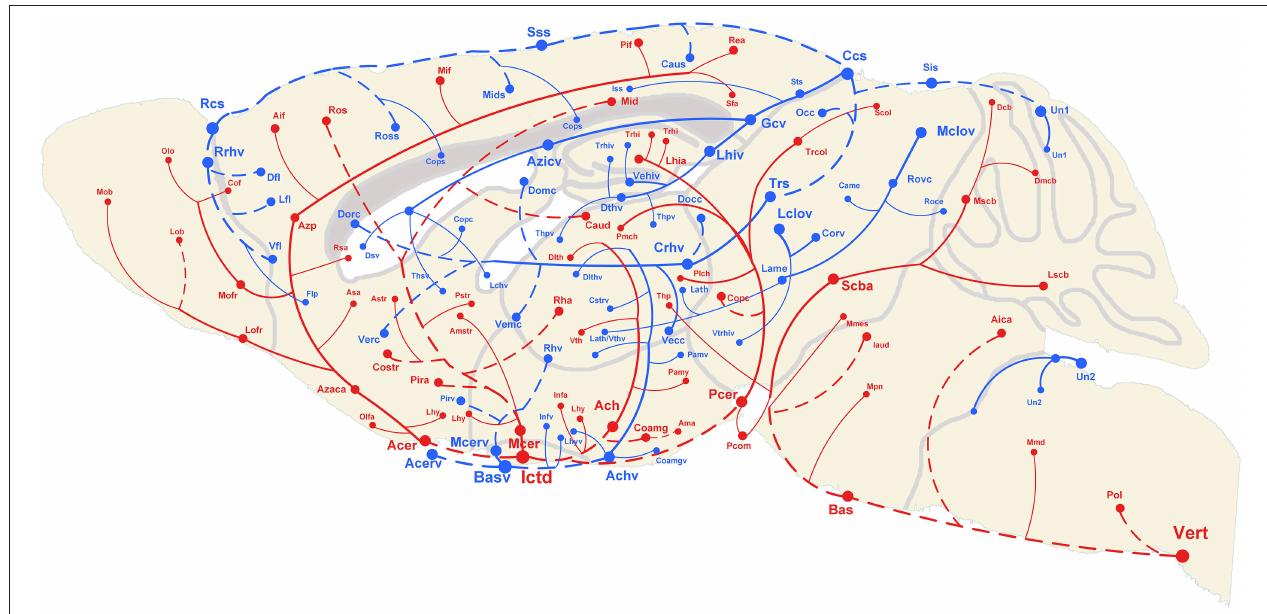
FIGURE 6 | Distribution map of the arterial and venous vascular system in the whole C57 mouse brain. Abbreviations and trending curves of the arteries and veins are presented in red and blue, respectively. Both the arteries and veins are presented in 3 levels using 3 different sizes from large to small of the font, sphere and link curves, which respectively represent the size of the vessel diameter, original/terminal points, and extending directions. The dotted curves and full curves respectively represent the vascular branches in the pial surface and inside the brain. A tree of abbreviations and full names of the vessels is presented in Figure 4 .